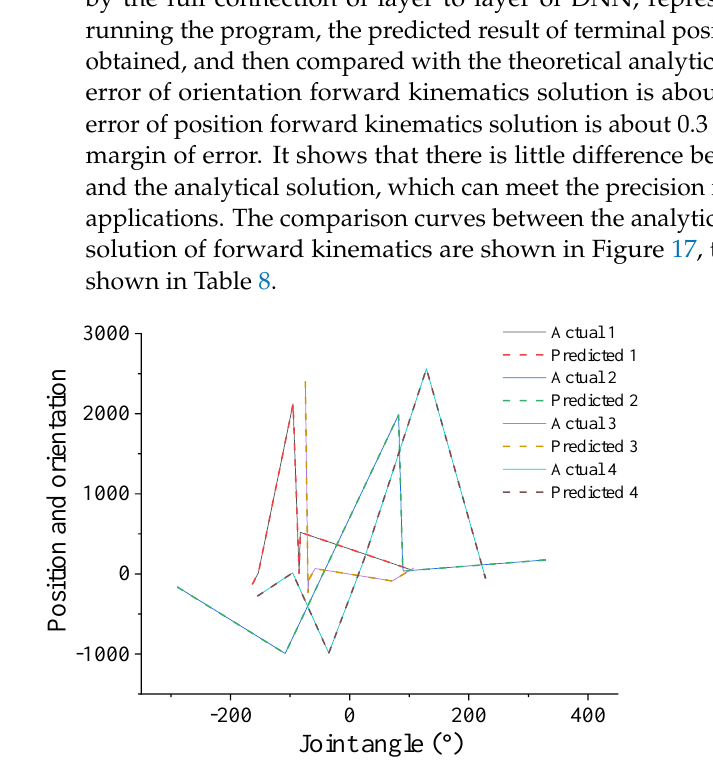
Figure 17. Comparison curves of analytic and predictive solutions of forward kinematics. Table 8. Comparison of analytic and predictive solutions of forward kinematics.